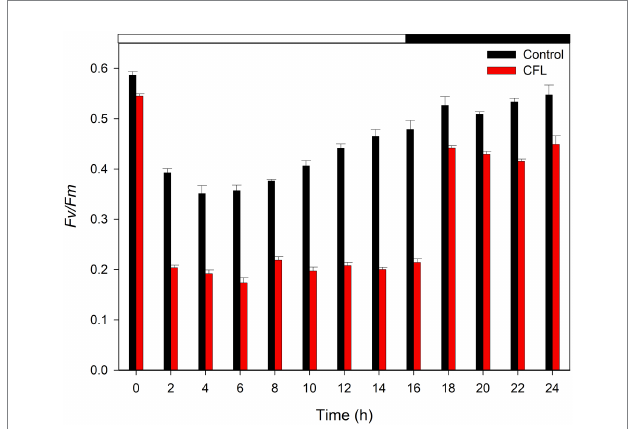
FIGURE 3 F v /F m ratio of synchronous control (black bar) and CFL–treated (red bar) Galdieria sulphuraria cultures, showing the photochemical maximum quantum efficiency of PSII. The dark phase is indicated by the black bar above the graph. The data are plotted as means of biological triplicates. The error bars represent standard deviations (±SD). For details of statistical analysis (multiple linear regression) see Supplementary Table S1.